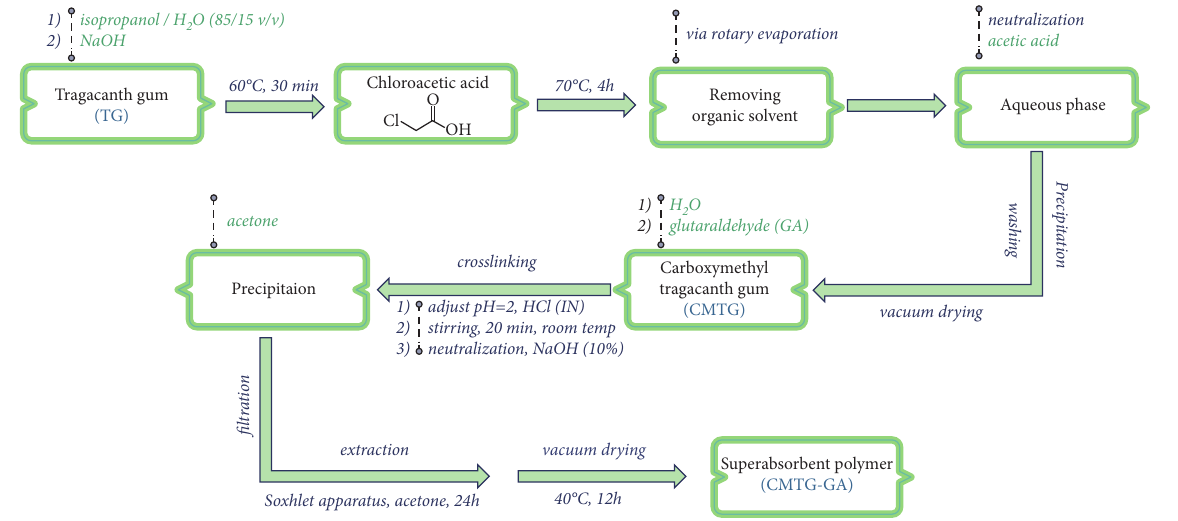
Figure 2: Schematic representation of the stepwise synthesis process of CMTG-GA. Table 1: Weight ratios of GA to CMTG (wt %).